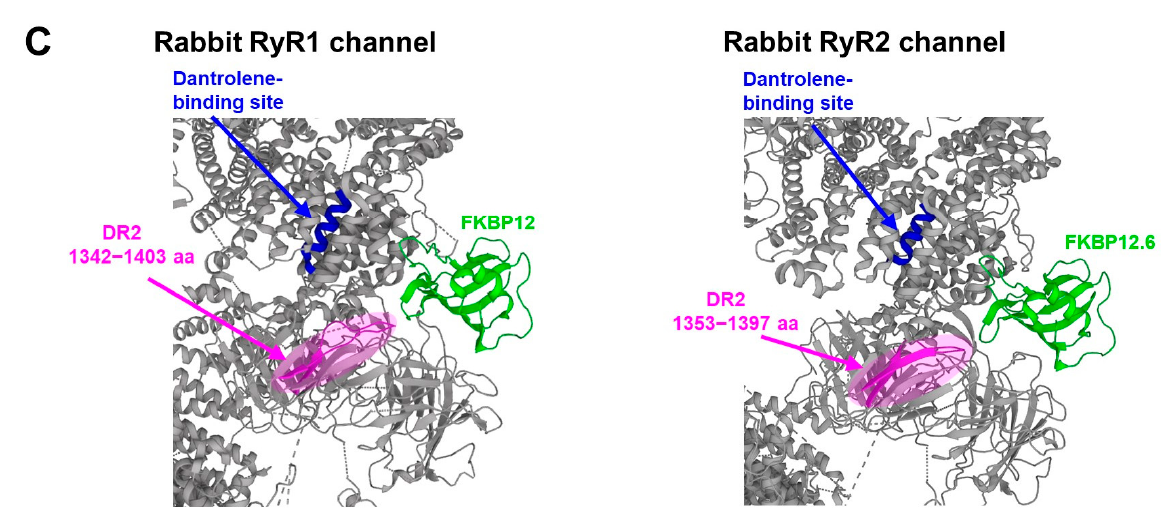
Figure 1. Structural aspects of dantrolene interaction with RyR isoforms. ( A ) A multiple-sequence alignment of the dantrolene-binding sequences located within all three RyR isoforms [19,160] from indicated mammals. The non-conserved residues are boxed in red. The sequences were taken from the UniProtKB database. ( B ) Cryo-EM 3D maps (cytosolic view) of the rabbit RyR1 (left) and the rabbit RyR2 (right) channels. The dantrolene-binding site is shown in blue [19,160], the phosphorylation domain in red [174], and FKBP12/12.6 in green [197,198]. ( C ) Zoomed-in view of the DR2 in one of four RyR1 (left) and RyR2 (right) subunits shown in magenta [199]. As the DR2 region is structurally unresolved, we highlighted two β -sheets within RyR1 ( β 1:1287 − 1290 aa and β 2:1438 − 1439 aa), as well as RyR2 ( β 1:1300 − 1304 aa and β 2:1426 − 1431 aa) subunits that closely surround the DR2 region. The dantrolene-binding site in blue and FKBP12/12.6 in green are also shown. The cryo-EM 3D structure of RyR1 (PDB ID: 3J8H [198]) and RyR2 channels (PDB ID: 5L1D [197] were taken from the Protein Data Bank available at rcsb.org [200]. UniProt #, UniProt accession number.